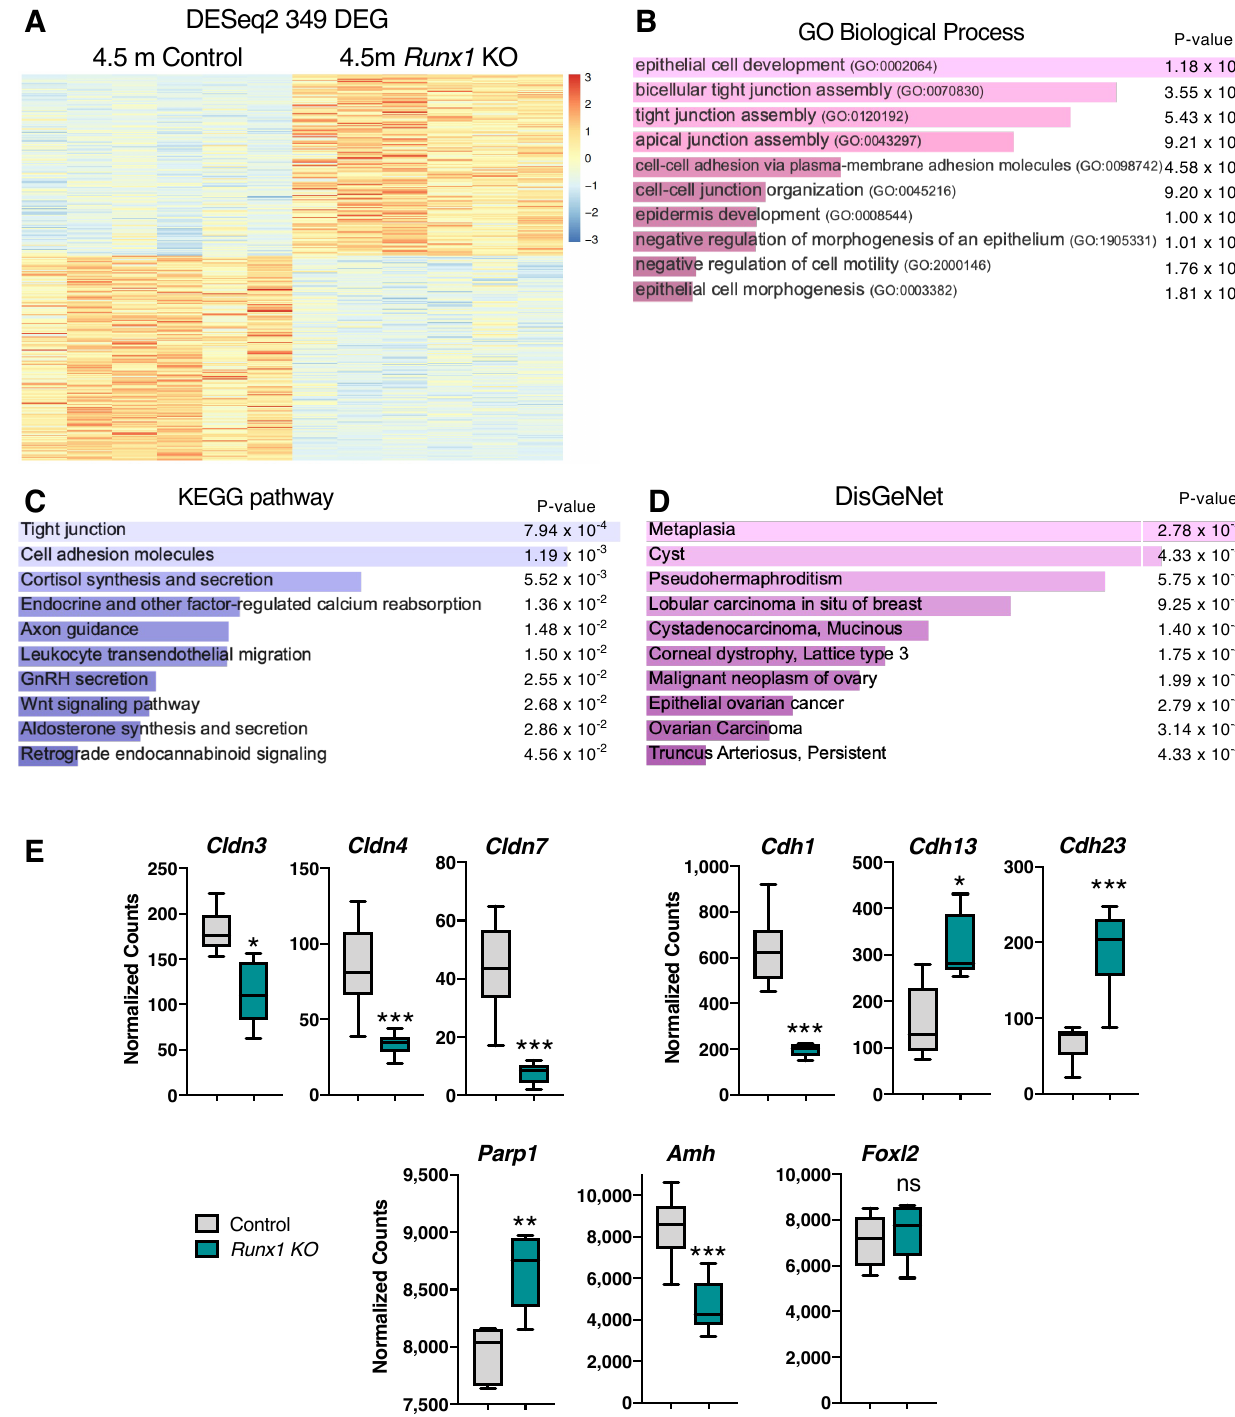
Figure 5. Identification of the differentially expressed genes and pathways in Runx1 knockout ovaries. ( A ) Heat-map of the 349 differentially expressed genes (DEGs) in Runx1 KO vs. control ovaries at 4.5 months identified by RNA-seq ( n = 6/genotype). ( B ) Gene Ontology Biological Process analysis based on DEGs. ( C ) KEGG pathway analysis based on DEGs. ( D ) DisGeNet analysis, which identified human diseases associated with the DEGs. ( E ) Examples of significantly differentially expressed genes in Runx1 KO vs. control ovaries at 4.5 months. Boxplots represent the DESeq2-normalized counts from RNA-seq data. Values are presented as mean ± SEM ( n = 6/genotype); ns, not significant; * p < 0.05; ** p < 0.01; *** p <